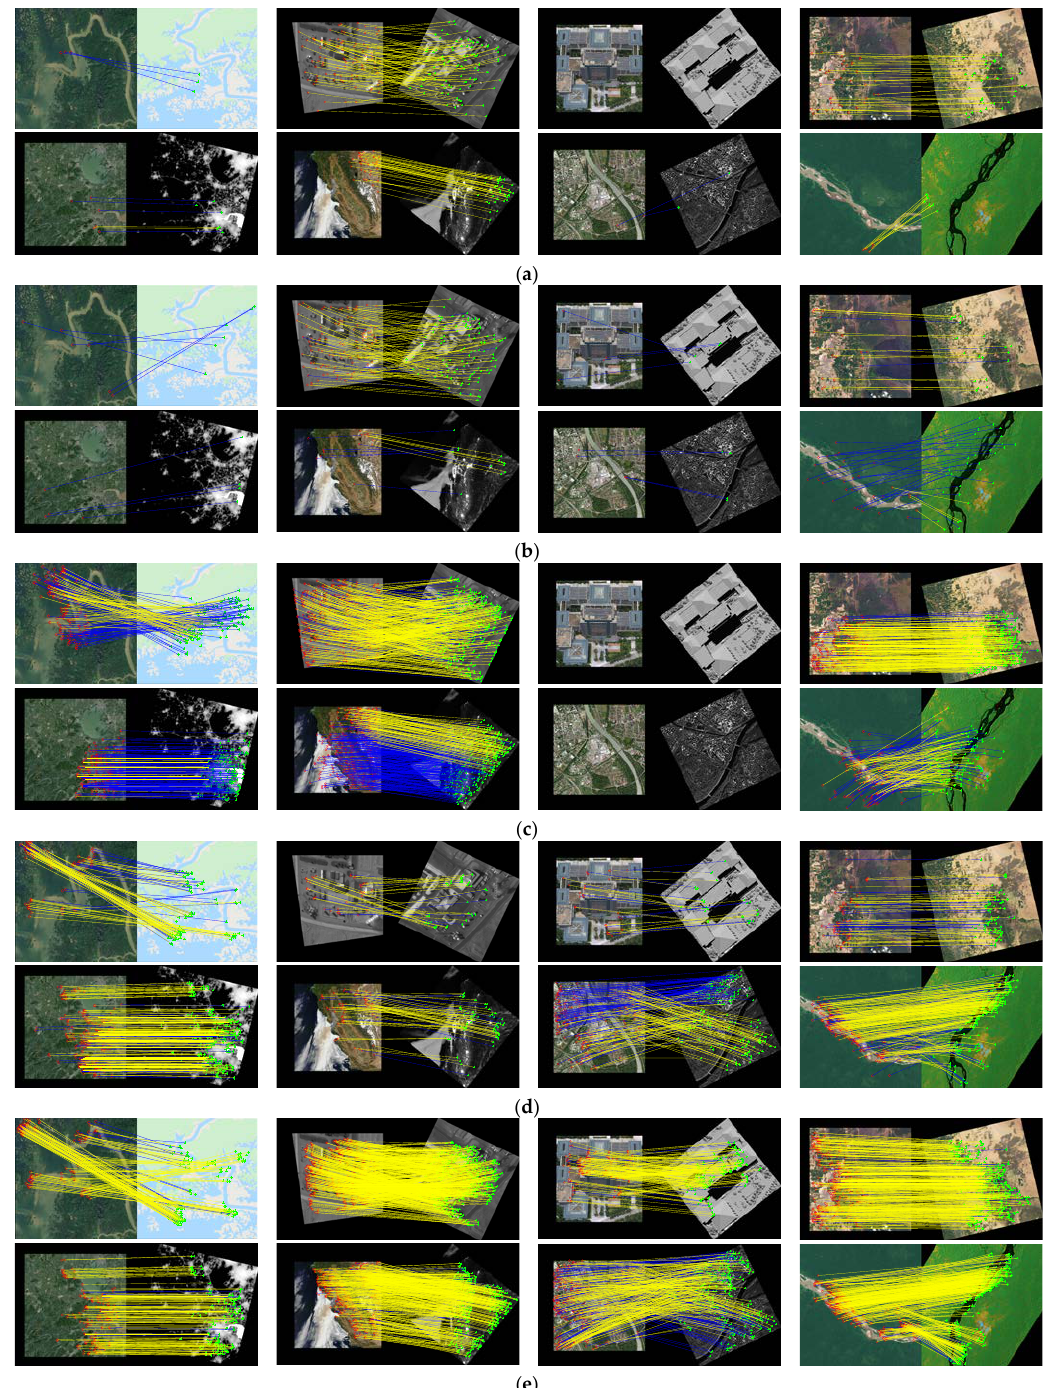
Figure 6. Qualitative comparison results of the sample data. The processed images are as follows: (cid:16) (cid:17) (cid:16) (cid:17) (cid:0) − π (cid:1) − 5 π − 3 π optical–map , optical–infrared , optical–depth , optical–optical 2 14 14 (cid:17) (cid:17) (cid:16) (cid:16) (cid:0) π (cid:1) (cid:0) π (cid:1) 3 π 5 π night , day–night , optical–SAR , and optical–SAR . The red circles and the green 2 14 14 14 crosshairs in the figure correspond to the feature points on the reference image and the sensed image, respectively; the yellow lines and the blue lines represent the correct matches and the incorrect matches, respectively: ( a ) the results of PSO-SIFT; ( b ) the results of MS-HLMO; ( c ) the results of CoFSM; ( d ) the results of RI-ALGH; and ( e ) the results of the proposed